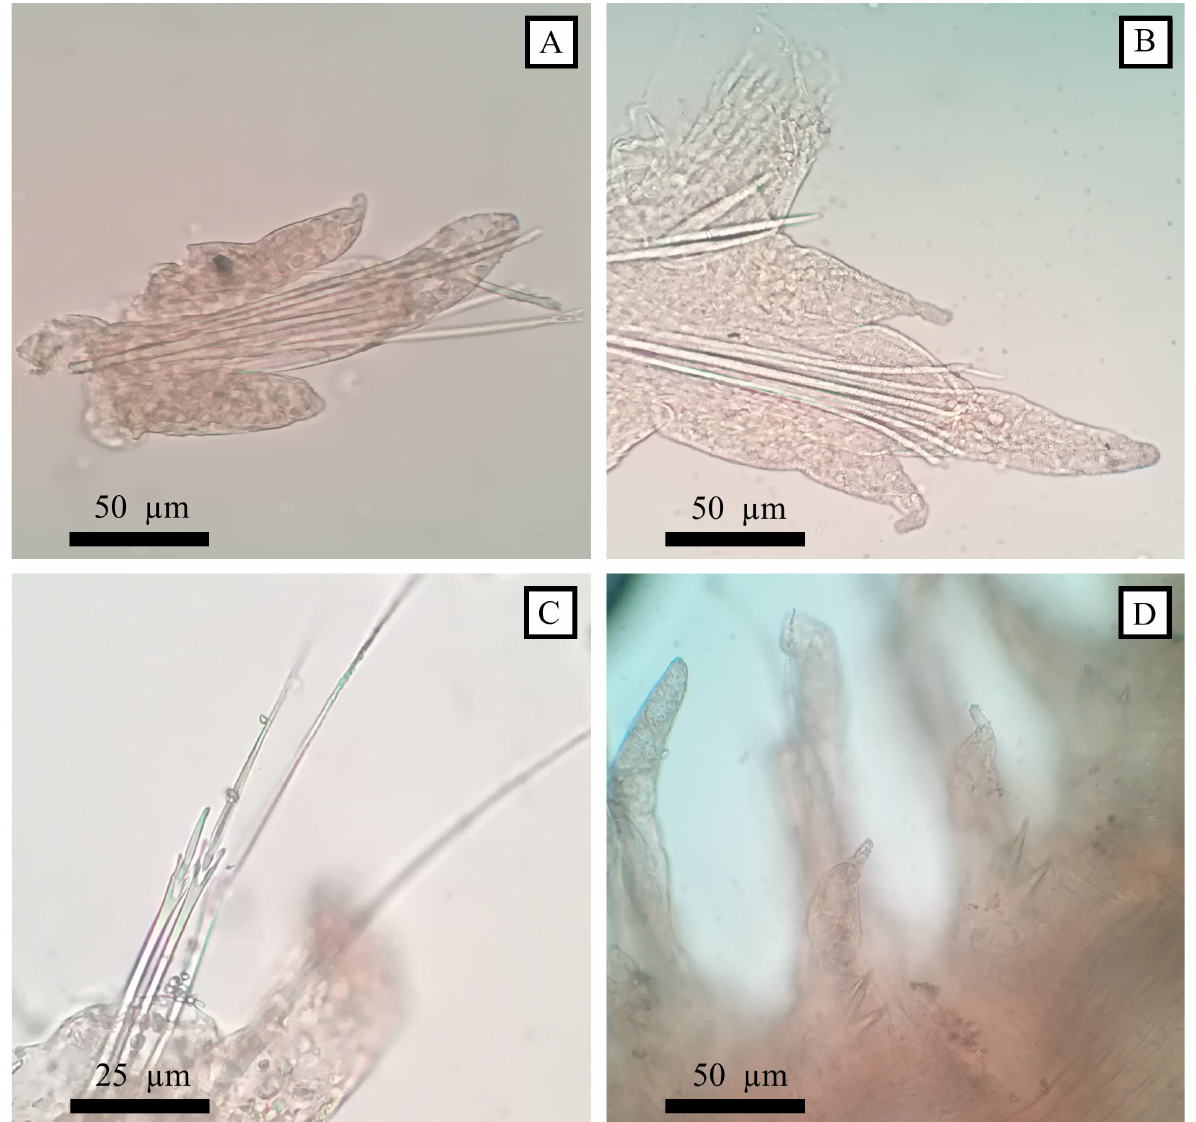
Figure 3. Goniadella bobrezkii. A. Anterior parapodium. B. Posterior parapodium. C. Chaetae. D. Dorsal view of posterior